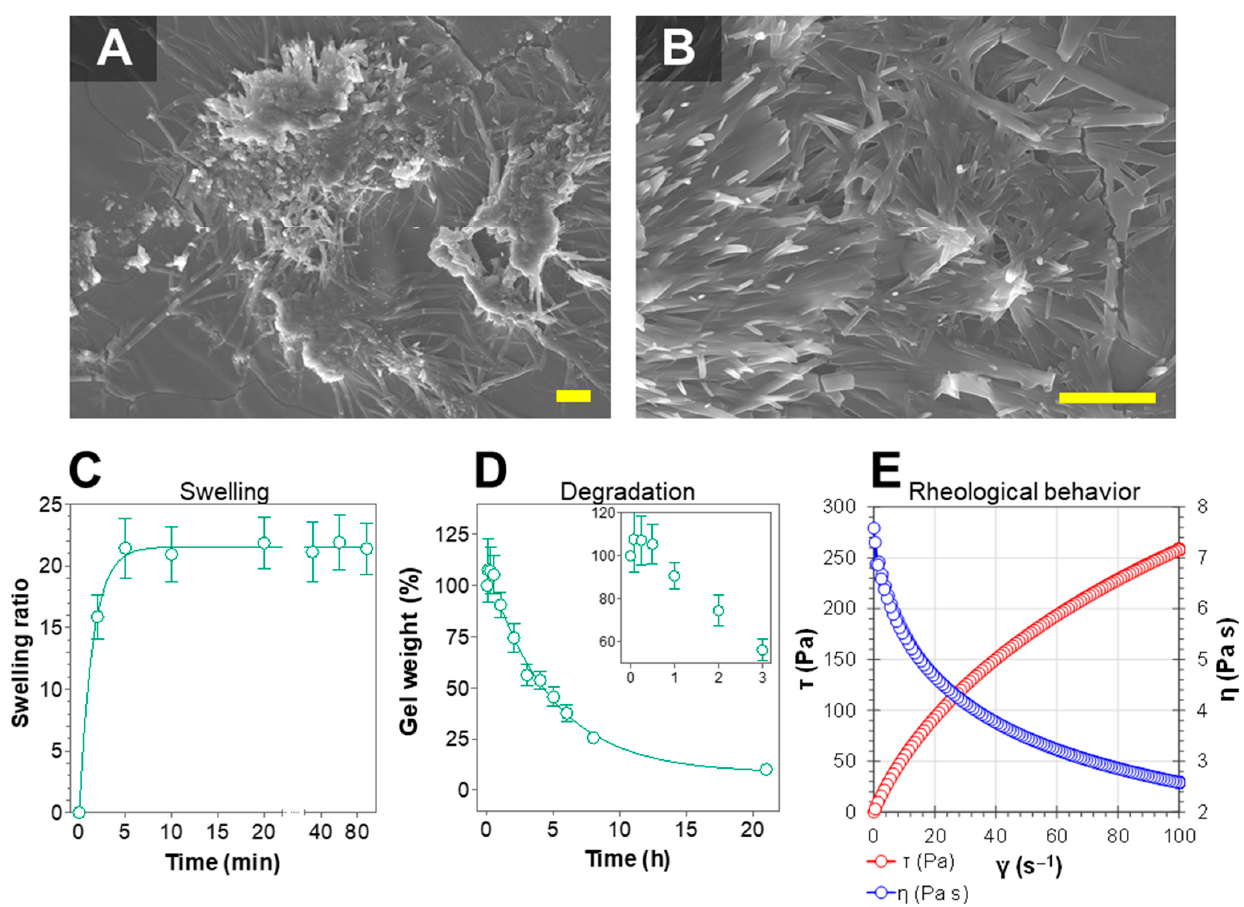
Figure 3. Characterization of KT hydrogel. ( A , B ) SEM images of KT hydrogel at different magnifications. The gel is formed by sodium alginate polymers that self-assemble to form fibers with diameters of around 100 nm. Scalebar represents 5 μ m. ( C ) Swelling ratio of KT hydrogels upon immersion in PBS. The kinetics followed a first-order (one-phase exponential association) model ( D ) Degradation of KT hydrogels in PBS. Inset shows a 7% weight increase during the first hour, in accordance to swelling results. After one hour, degradation follows a one-phase exponential decay kinetics. Values represent Means ± SD ( n = 3). ( E ) Rheogram of KT hydrogel at 32 °C. The flow curve represents shear stress ( τ in Pa) (left axis) or viscosity ( η in Pa·s) (right axis) as a function of the shear rate ( γ in s − 1 ).